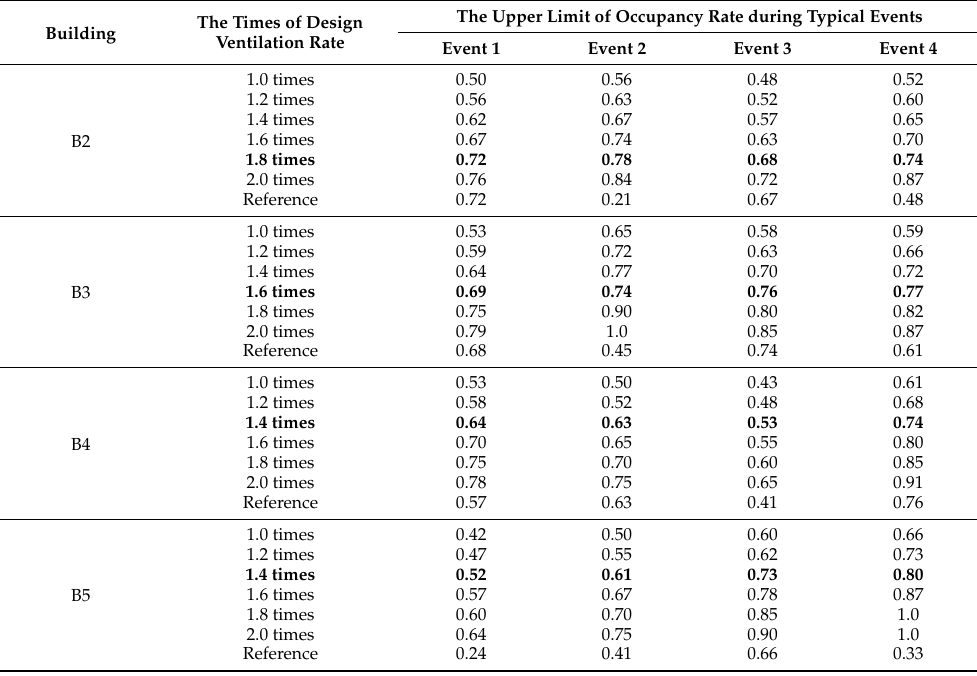
Table 8. The upper limit of occupancy rate during typical events under different ventilation